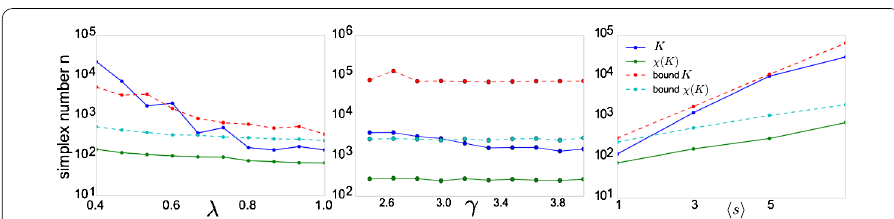
Figure 2 Reduction of simplicial complex size. The figure shows an example of simplicial complex (a) and its correspondent dual complex (b) . Each facet of the original simplicial complex is represented by a node in the dual complex, and k + 1 nodes span a k -simplex if the corresponding k + 1 facets have at least a node in common. In both simplicial complexes, the facets are colored according to their dimension. It is easy to see that applying the complexity reduction to the simplicial complex (a) reduces the total number of simplices from 91 to 28, while fixing the homology (both complexes have one connected component, and one hole (1-dimensional cycle).